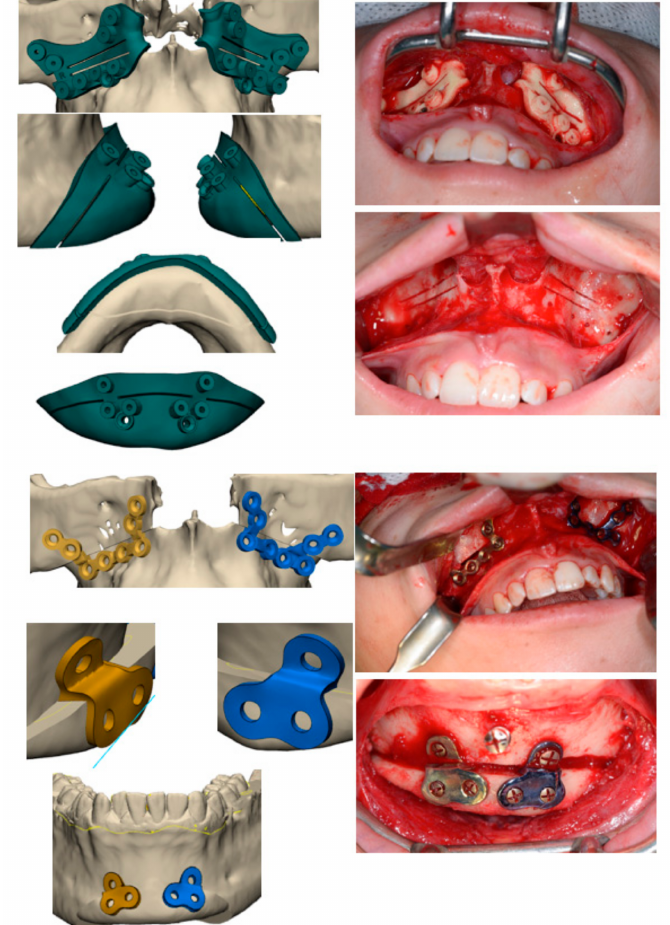
Figure 4. Three-dimensional planning and intra-surgical use of 3D individualized cutting guides realized according to surgical movements planned. Design, planning and intra-surgical use of 3D individualized stabilization